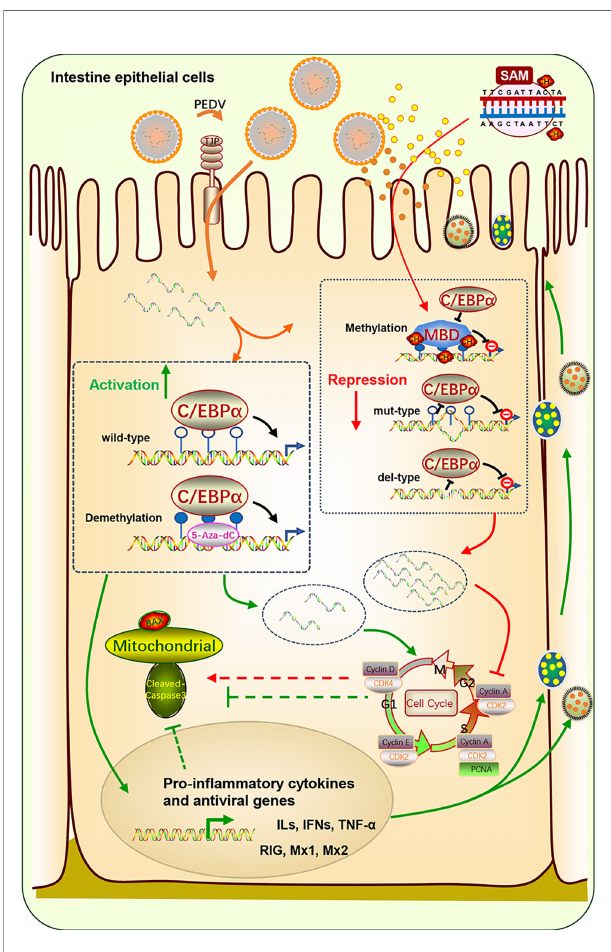
FIGURE 7 | Schematic diagram of C/EBP a -modulated TFF1 via mC-6 methylation in the PEDV-induced jejunum in fl ammation. TFF1 is highly expressed in intestinal epithelium during PEDV-infected jejunum in fl ammation. It improves the intestinal functions through reducing pro- in fl ammatory cytokines and facilitating the inhibition of the virus replication by increasing antivirus genes. This process further bene fi ts the porcine intestinal epithelium cell proliferation and growth by inhibiting apoptotic kinases. The mucous repairment is therefore help the host resistant to the porcine coronavirus infection. Mechanistically, this virus affects DNA methylation pro fi le especially the mC-6 loci methylation including the key factor C/EBP a binding sites. The transformation alteration of C/EBP a is detrimental for the speci fi c bind to TFF1 . This process determinates the TFF1 action of jejunum in fl ammatory responses suffer from PEDV fi ndings contribute to the fi eld of intestinal protection, anti- in fl ammation, and anti-coronavirus in porcine and other species.